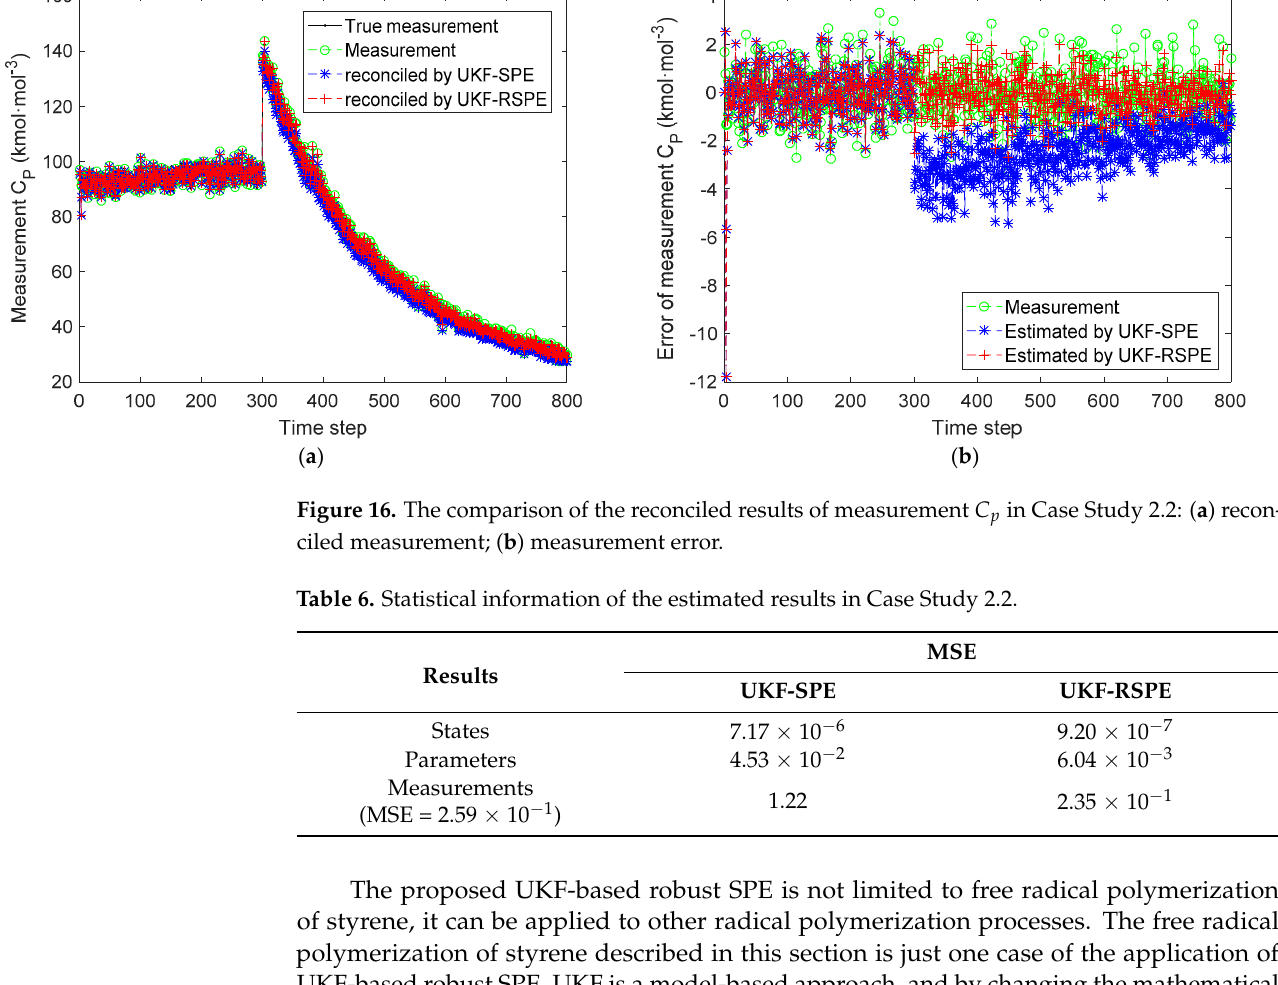
Figure 15. The comparison of the reconciled results of measurement (cid:101) T k in Case Study 2.2: ( a ) recon- ciled measurement; ( b ) measurement error.